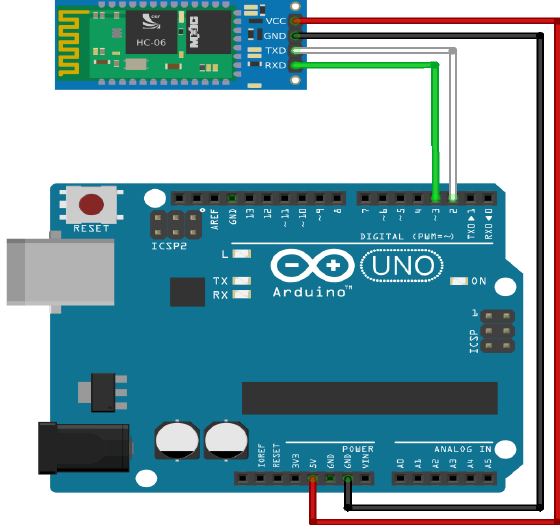
Figure 1. The connections between the Bluetooth Module HC-06 and the Arduino Uno.